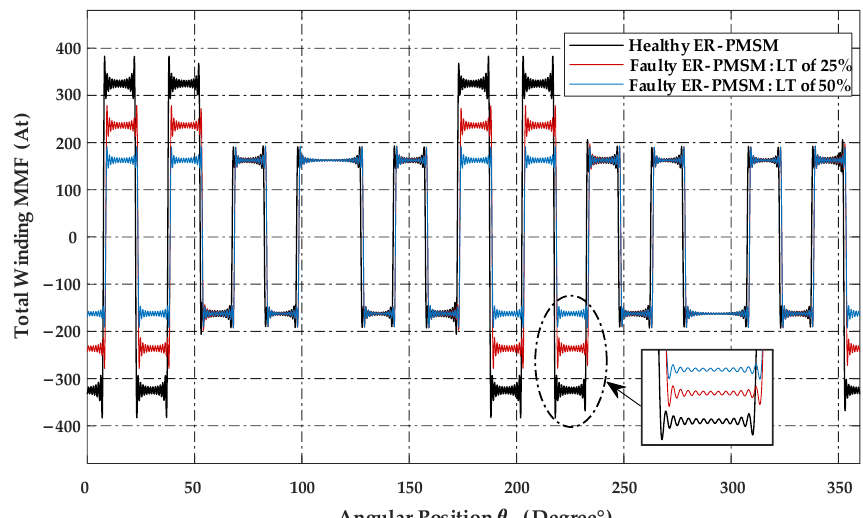
Figure 5. Healthy and faulty stator MMF distribution.